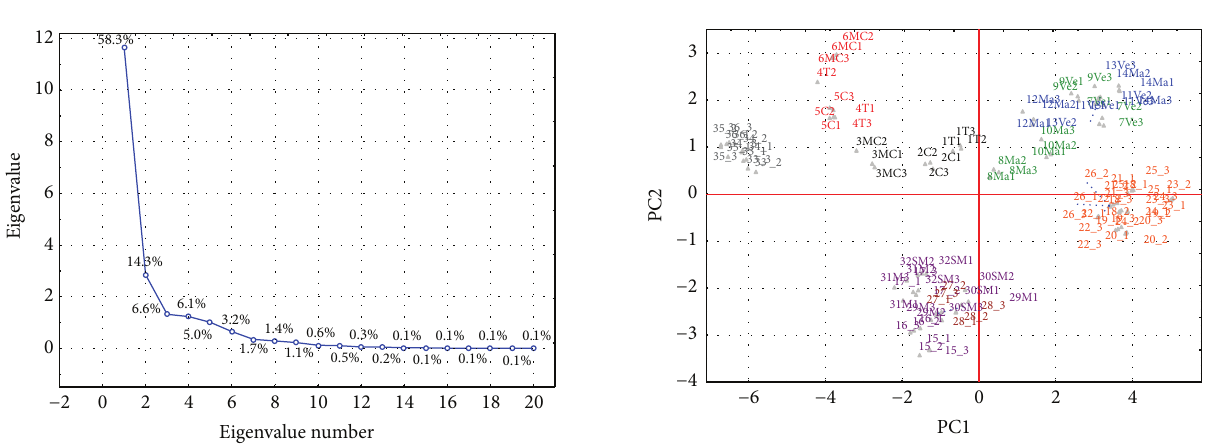
Figure 2: Scree plot obtained by performing PCA on the complete dataset.